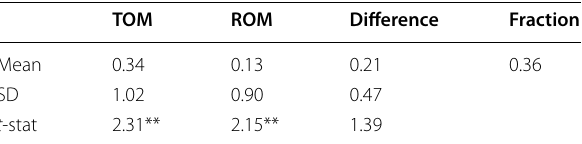
Table 6 T-test of means for “Turn-of-the-Month-Effect” of year 2016